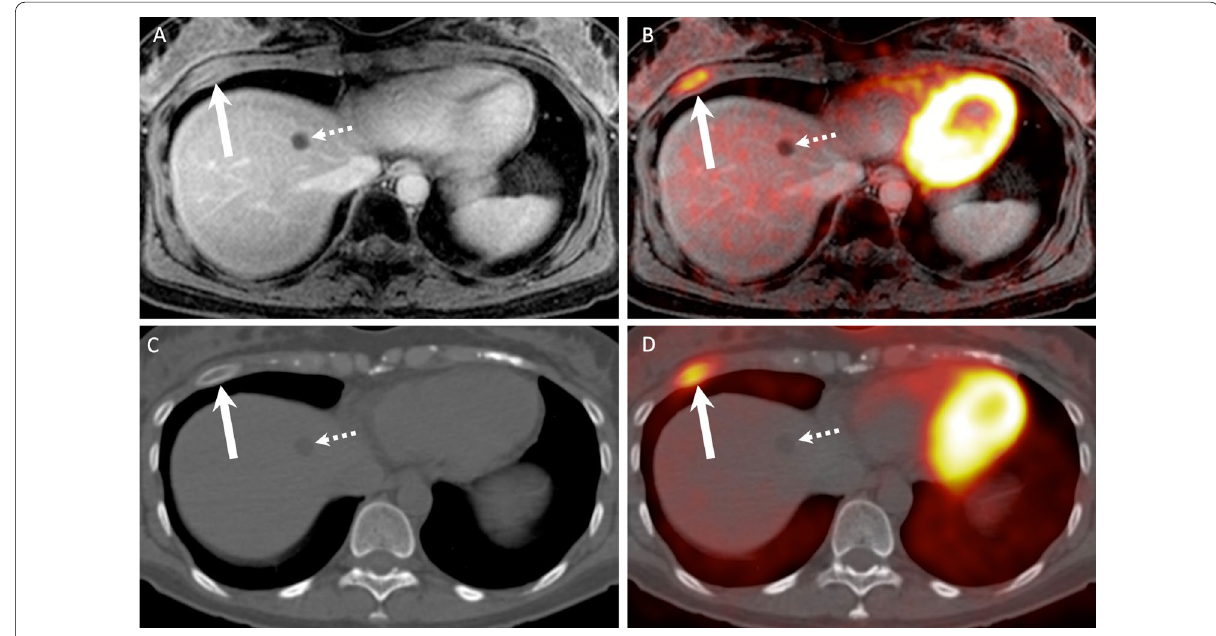
Fig. 4 Rib metastasis detected on both PET/MRI ( A , B ) and PET/CT ( C , D ) in a 42-year-old female without loco-regional recurrence after radiochemotherapy for a SCC of the paranasal sinuses. The rib lesion (arrows) shows a combination of high focal [ 18 F]FDG uptake (SUVmax on PET/MRI 6.3 and SUVmax on PET/CT 4.7) and an expansile aspect on MRI/CT (arrows). Note lesion enhancement on the contrast-enhanced = = fat-saturated MR image. The lesion was rated with a score of 5 on PET/MRI and with a score of 4 on PET/CT. Dashed arrows point at a liver